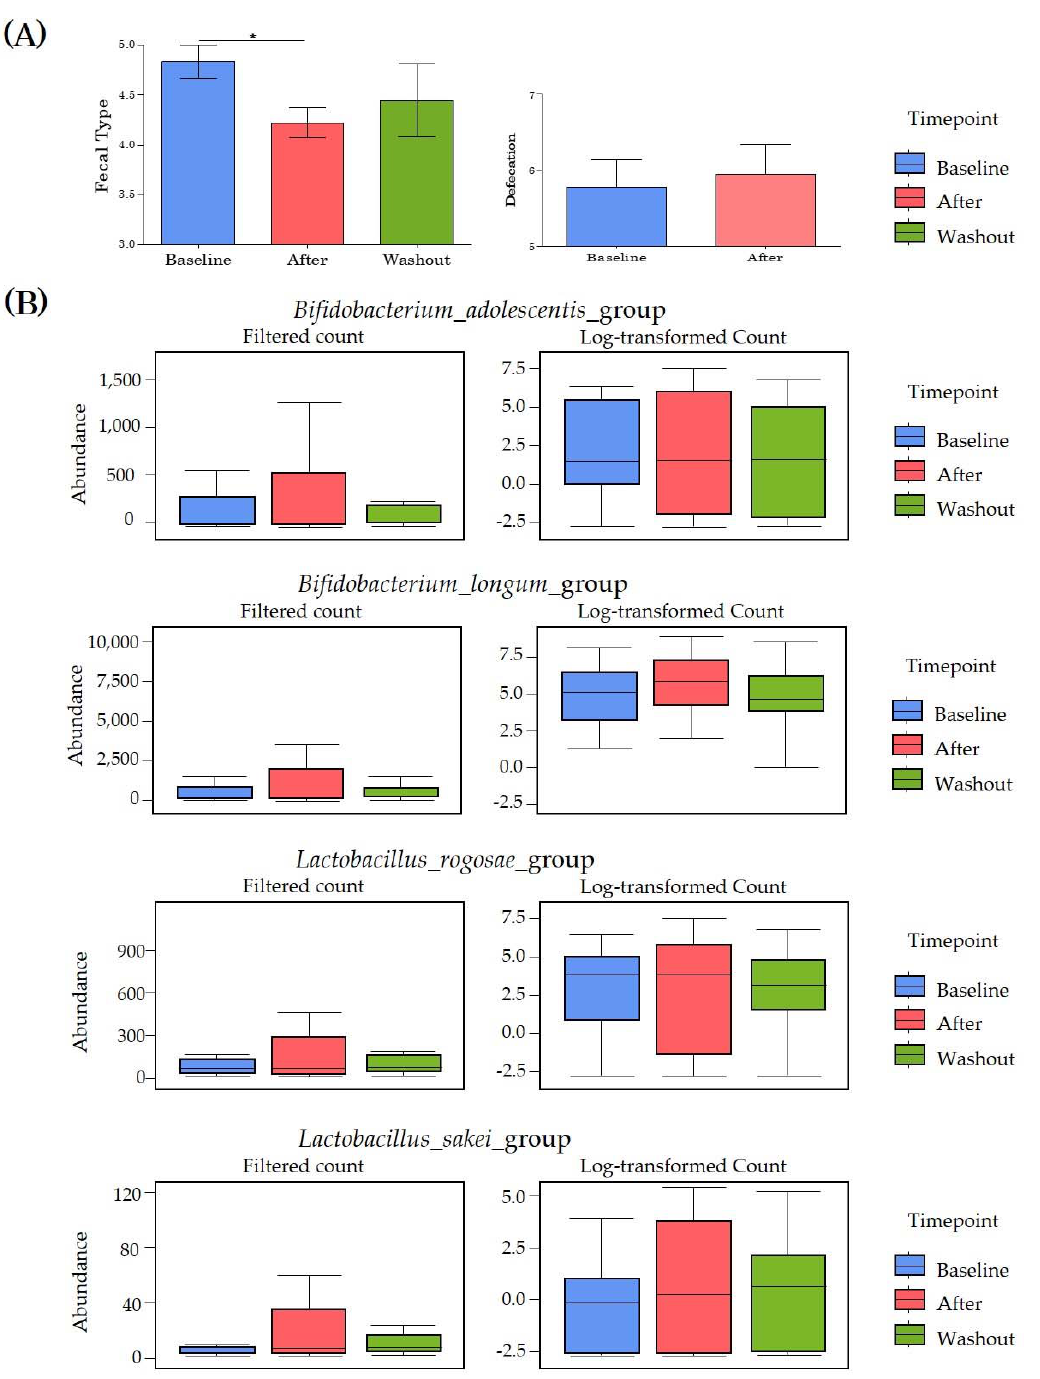
Figure 2. Changes in beneficial bacteria abundance and bowel activity of study participants at each time point. We observed which specific taxa were responsible for important global differences in microbial population composition between sample groups and tested all taxa individually for association with response variables. ( A ) Changes in stool type and bowel activity of participants at each time point. ( B ) Changes in the abundance of Bifidobacterium and Lactobacillus to observe changes in beneficial bacteria at each time point. * p < 0.05.